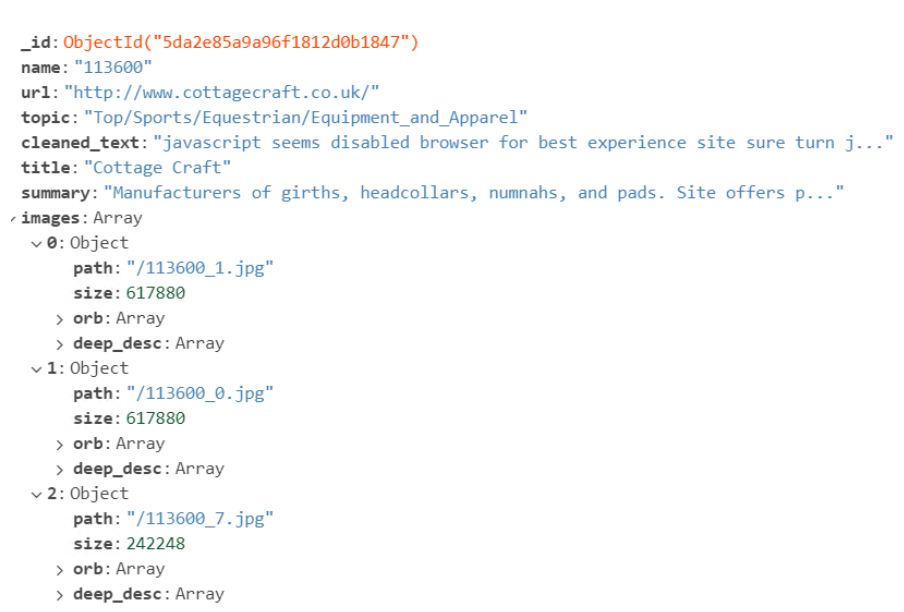
Figure 4. Document